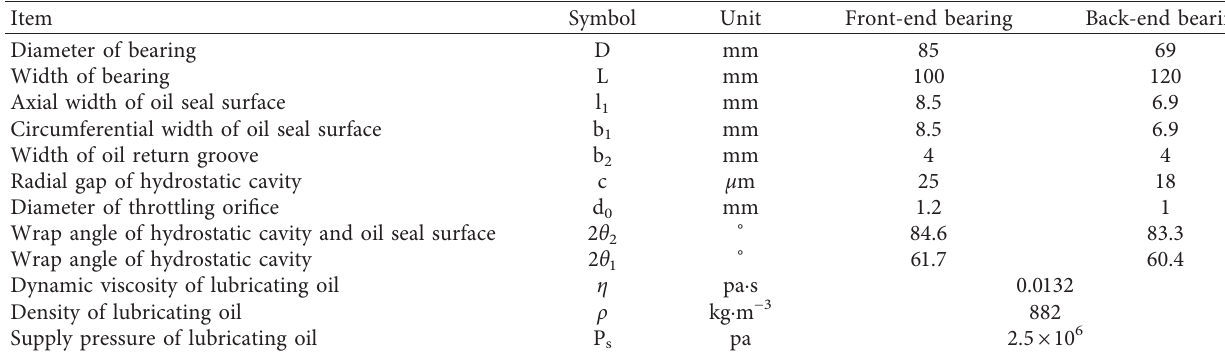
Table 2: Structure and working condition parameters of hydrostatic